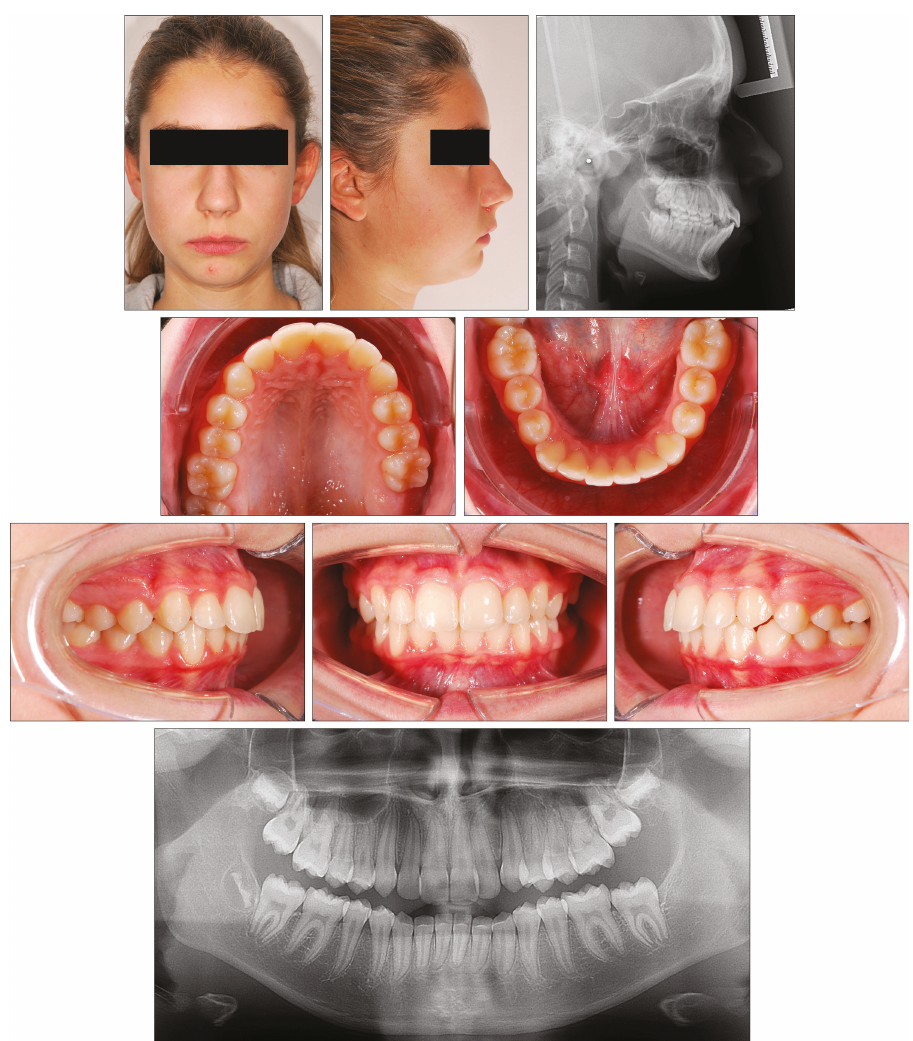
Figure 8: Case 2. Patient after 12 months of functional treatment with the Bionator and 3 months of fi xed appliance treatment when she was 12 years and 6 months